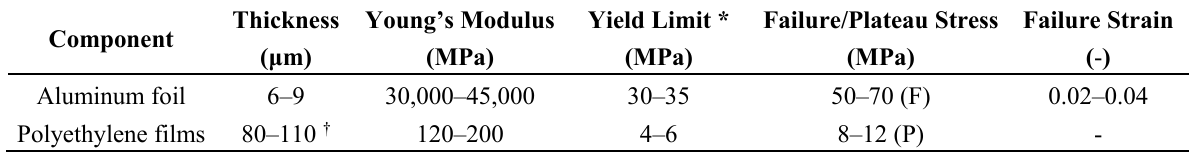
Table 1. Characteristic parameters of aluminum laminates in beverage